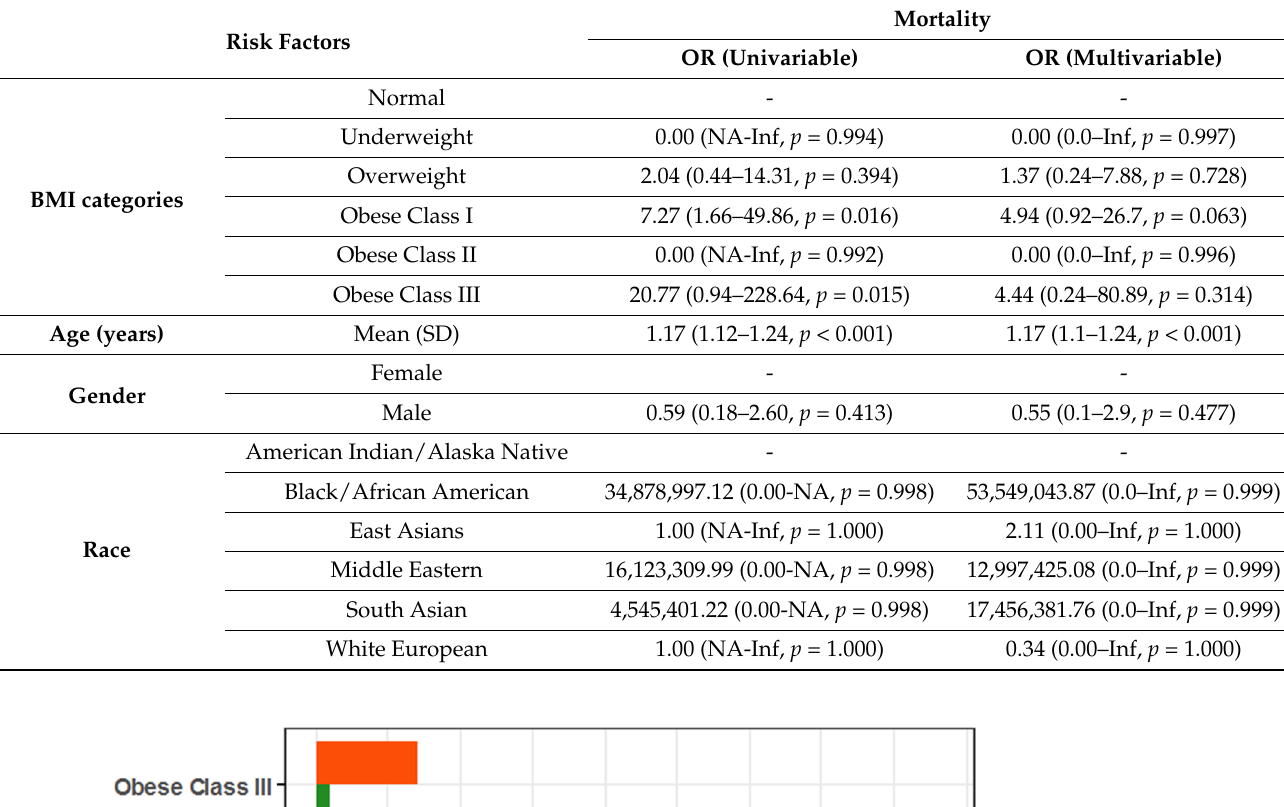
Table 3. Relationship between patient BMI and mortality due to COVID-19.